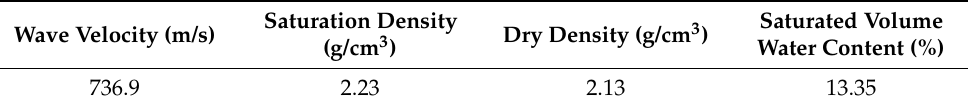
Figure 1. Test object and foundation parameters. Table 1. Basic physical properties of rock samples.